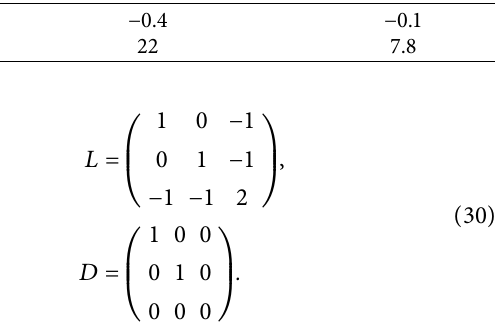
Figure 6: The error trajectories of leader and agents with c � − 0 . 4 in Example 2. (a) The error trajectories of v0 and v1. (b) The error trajectories of v0 and v2. (c) The error trajectories of v0 and v3. Table 2: Average time to zero of the variables’ error with increasing c in Example